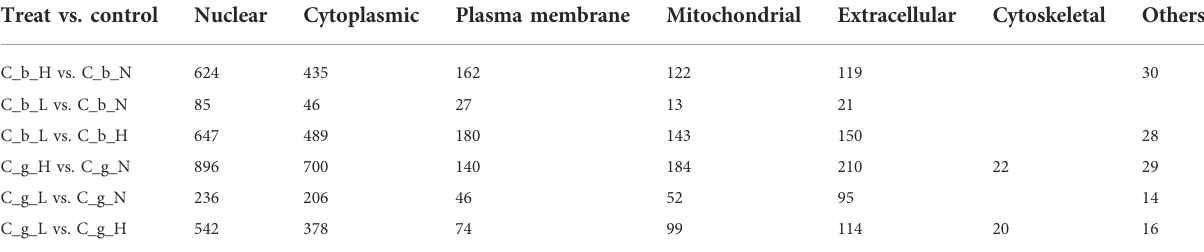
TABLE 2 Statistical analysis of subcellular localization. Treat vs.